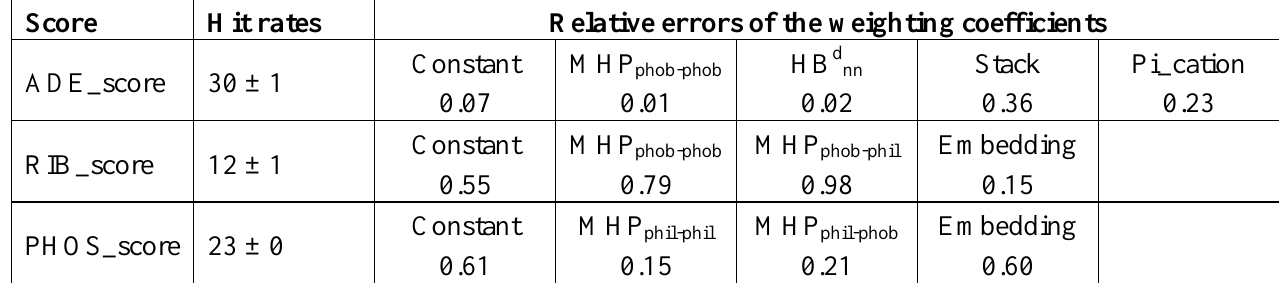
Table 2. Results of cross